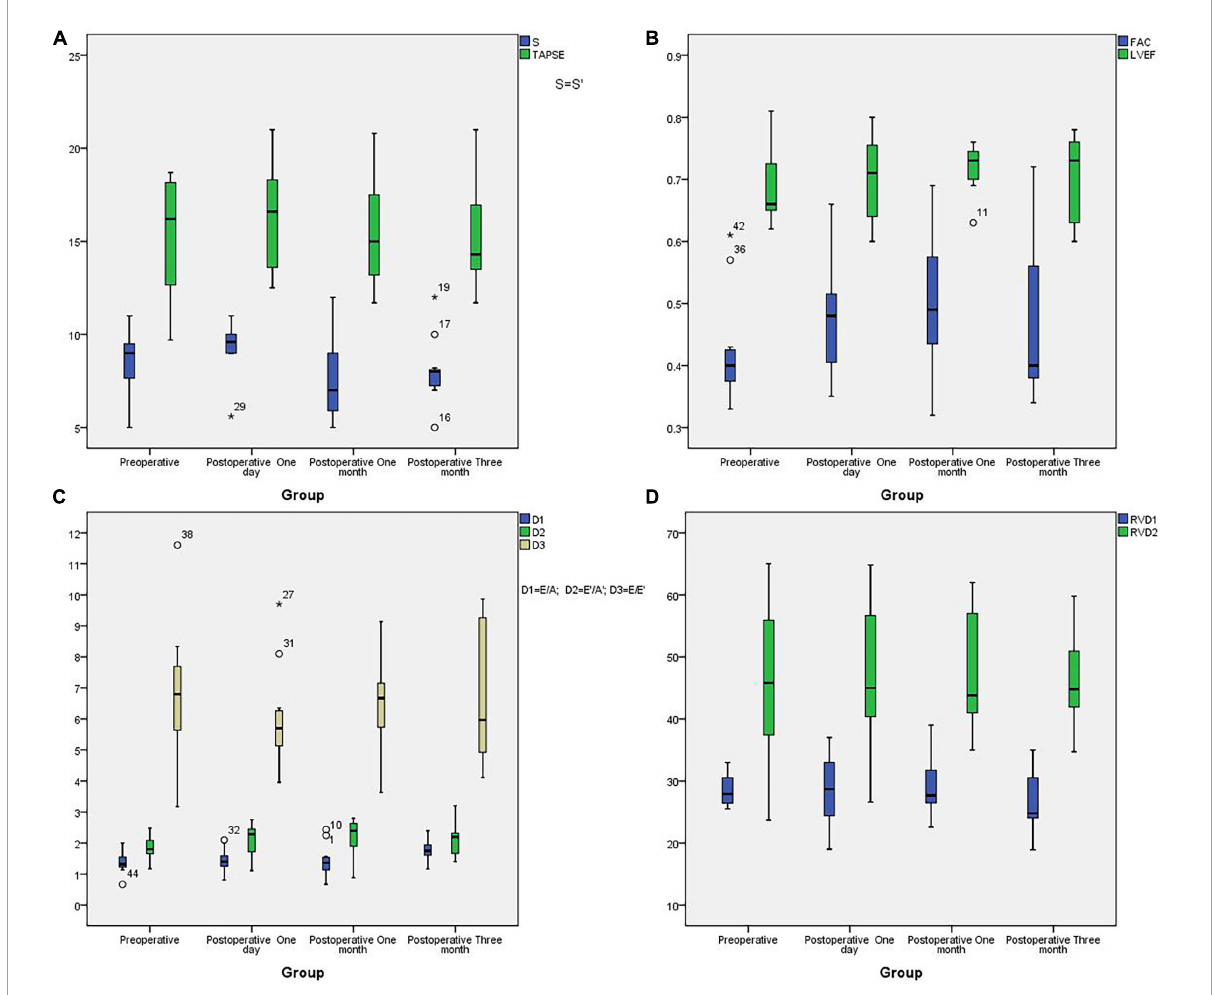
FIGURE6 The boxplots of echocardiographic parameters. (A) : The boxplots of S’ and TAPSE in different groups; (B) : The boxplots of LVEF and FAC in different groups; (C) : The boxplots of E/A, E (cid:48) /A (cid:48) and E/E (cid:48) in different groups; (D) : The boxplots of RVDA and RVD2 in different groups.